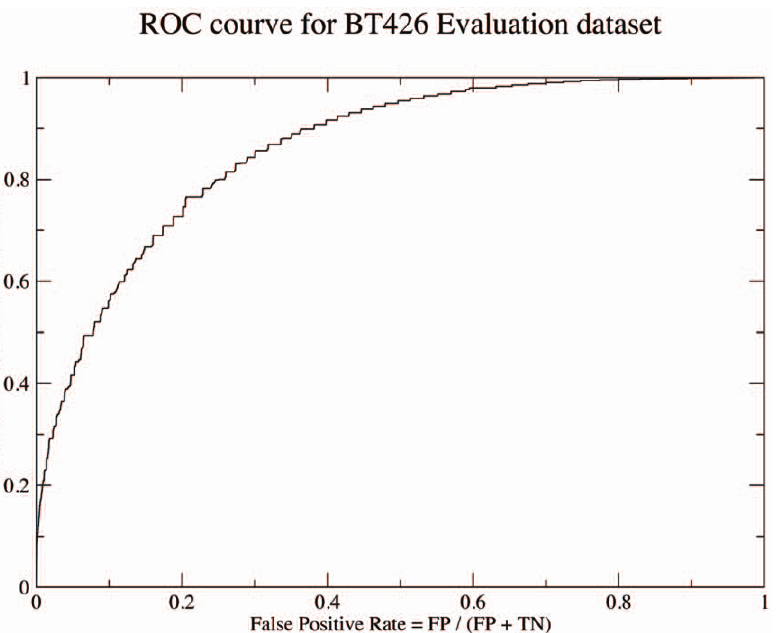
Figure 3. ROC curve for the evaluation of NetTurnP. The figure shows the ROC curve (True positive rate vs. False Positive Rate) for the evaluation of the NetTurnP against the BT426 dataset.